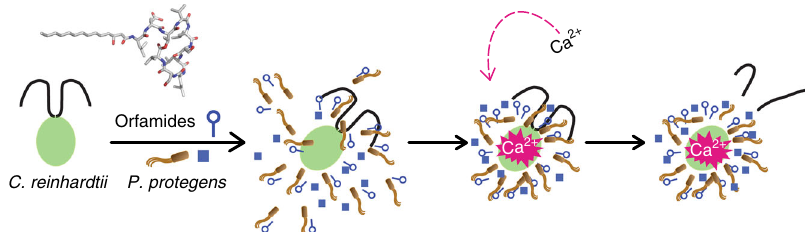
Fig. 6 Proposed model of paralysis of algal cells by P . protegens . During the antagonistic interaction of P . protegens with C . reinhardtii , the cyclic lipopeptide orfamide A as well as yet unknown other chemical mediator(s) (indicated by blue squares) produced by the bacteria accumulate around the algal cells. Orfamides and the other compound(s) elicit a cytosolic Ca 2+ signal in the green algae by triggering the in fl ux of external Ca 2+ , at least in the case of orfamide A. Algal cells then become paralyzed by de fl agellation, which seems to help P . protegens to acquire